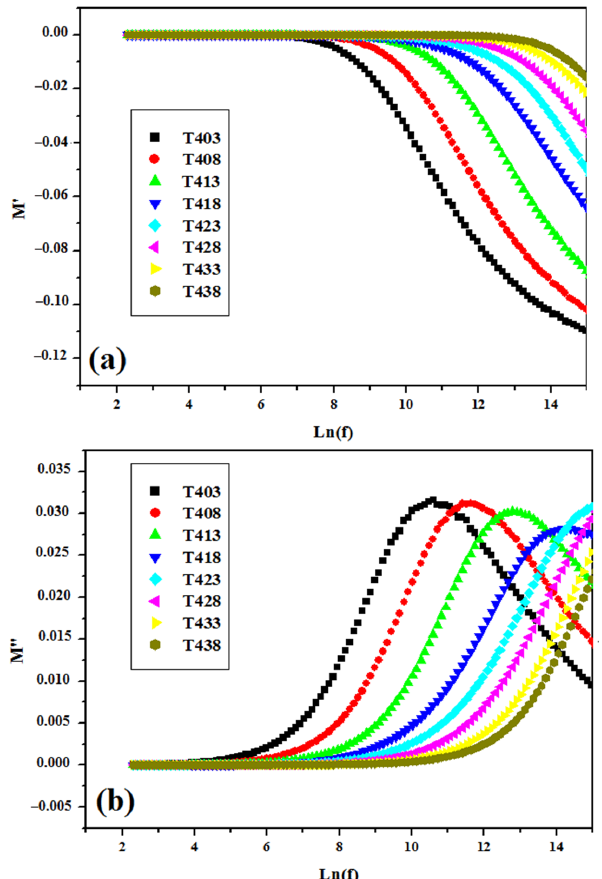
Figure 13. ( a ) M’ versus Ln(f) in the range 403–438 K and ( b ) M ″ versus Ln(f) in the range 403–438